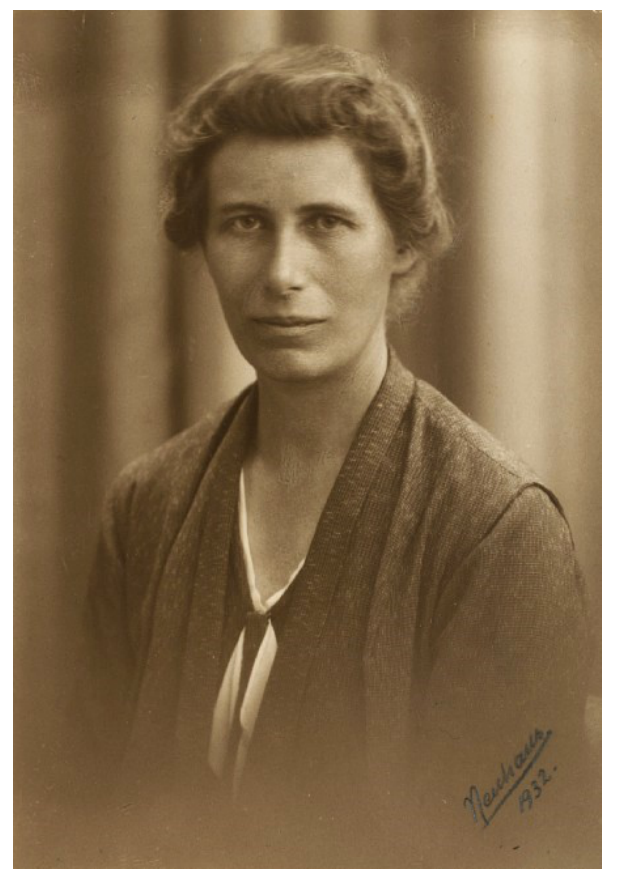
Figure 4. Inge Lehman, director of the Seismology Department of the Danish Geodetic Institute, 1932 (Royal Danish